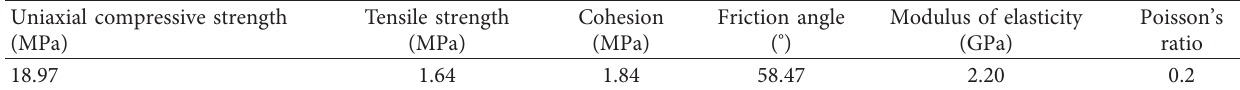
Table 1: Mechanical parameters of rock samples.